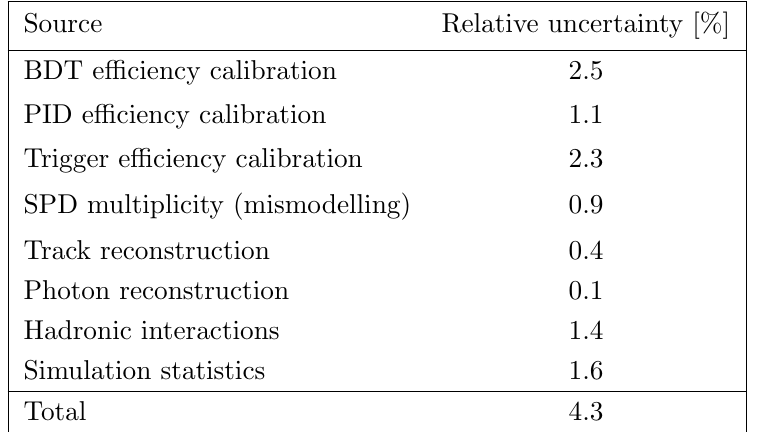
hardware-stage trigger e(cid:14)ciency, is estimated with simulated data by varying the value